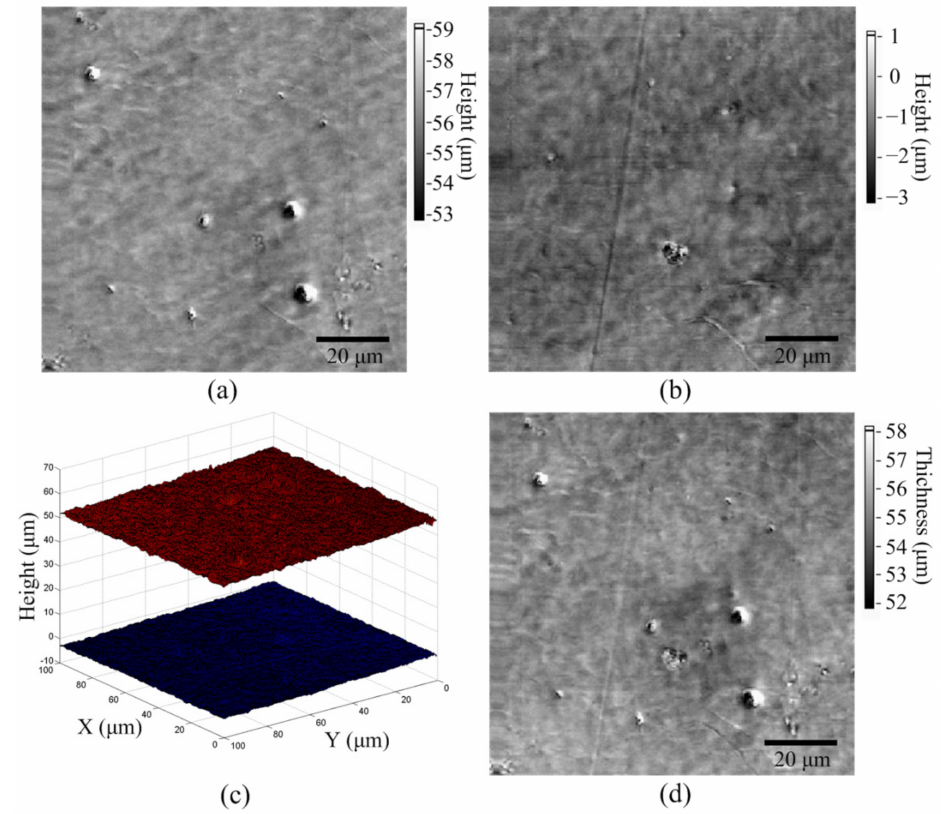
Figure 5. Height images of ( a ) upper and ( b ) lower surfaces. ( c ) 3D image of top and bottom surfaces. ( d ) Thickness